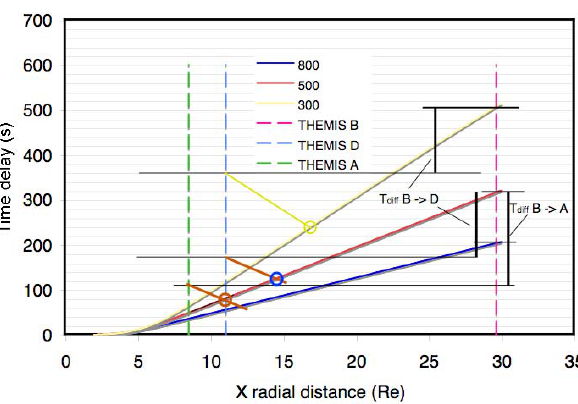
Fig. 12. Auroral luminosity curves for ∼ 08:12 event. Figure 12. Auroral luminosity curves for ~8:12 event. topshere is considerably “smaller” here at ∼ 10 R E and the magnetic signals are a mixture of several nearby current sys- tem we had no choice but to use the “sudden impulsive” start of magnetic signature and we chose the sudden increase of the By component at 08:35:24. On Fig. 19 we present the auroral image collages rep- resenting the auroral display at the time of these signa- tures. Figure 19a depicts the auroral situation at the time of the ground based expansion onset. Figure 19b shows the aurora when the magnetic signature reaches THEMIS A. THEMIS A is reasonably well placed to be near the local time region nearest the onset. Figure 19c shows the au- rora when the magnetic signature reaches the foot point of THEMIS B located at 29.5 R E down tail. Figure 19d is the image collage of the aurora when the magnetic signature reaches THEMIS E and